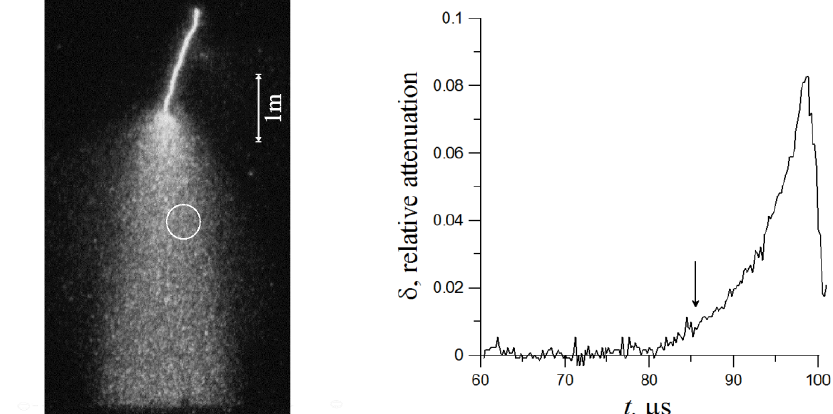
Fig. 2. a - high-speed camera image of the breakthrough phase of positive leader. b - relative attenuation of the microwave radiation . The moment of the fast camera exposure is